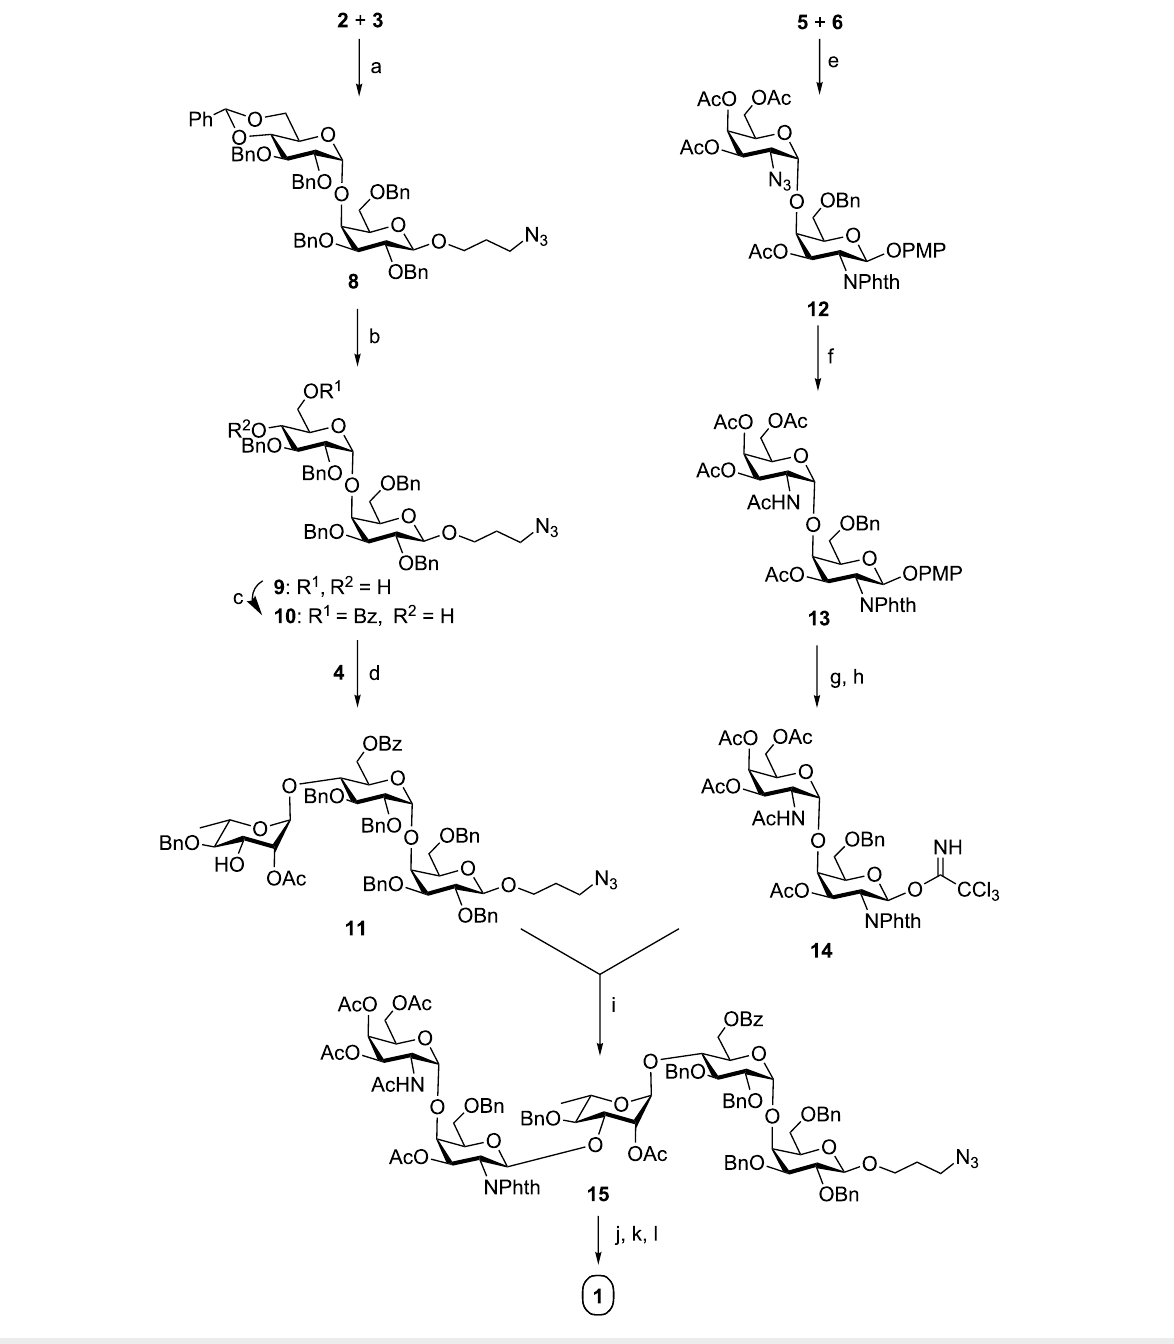
Scheme 2: Reagents: (a) N -iodosuccinimide (NIS), TMSOTf, CH 2 Cl 2 , MS 4 Å, − 30 °C, 1 h, 72%; (b) HClO 4 /SiO 2 , CH 3 CN, rt, 20 min, 85%; (c) benzoyl cyanide, DCM/pyridine, rt, 2 h, 80%; (d) N -iodosuccinimide (NIS), TfOH, CH 2 Cl 2 , MS 4 Å, − 30 °C, 1 h, then 0 °C, 1 h, 77%; (e) NOBF 4 , Et 2 O/CH 2 Cl 2 (3:1), − 15 °C, 1 h, 75%; (f) PPh 3 , THF, 6 h, then Ac 2 O, pyridine, rt, 1 h, 84%;(g) CAN, CH 3 CN, H 2 O, rt, 1.5 h; (h) CCl 3 CN, DBU, CH 2 Cl 2 , − 10 °C, 1 h; (i) NOBF 4 , CH 2 Cl 2 , − 15 °C, 1 h, 70%; (j) i) NH 2 NH 2 ·H 2 O, CH 3 CH 2 OH, 80 °C, 8 h, ii) acetic anhydride, pyridine, rt, 1 h; (k) H 2 , 20% Pd(OH) 2 /C, CH 3 OH, rt, 24 h; (l) 0.1 M CH 3 ONa, CH 3 OH, rt, 3 h, 58% overall